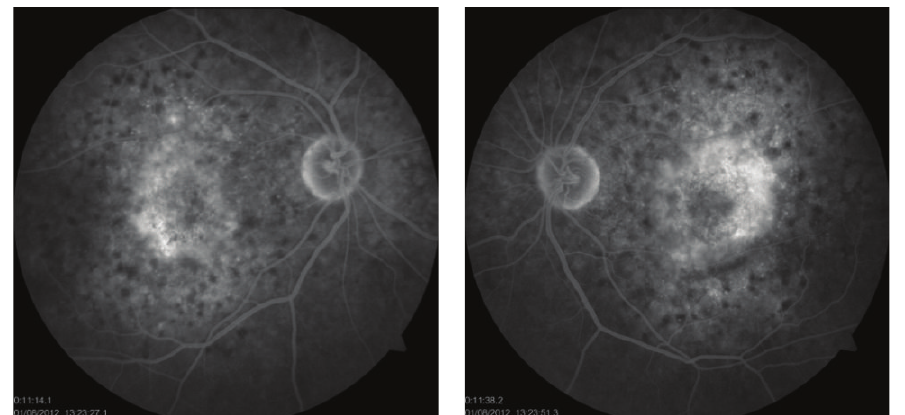
Figure 4: Fluorescein angiography.